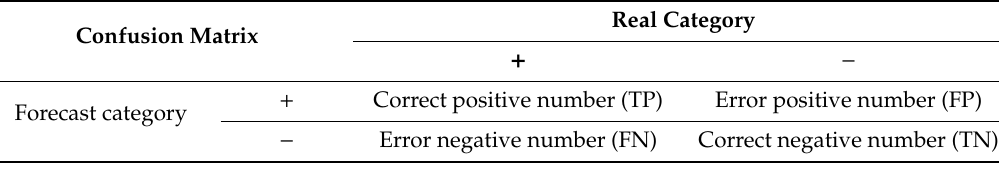
Table 1. Confusion matrix of two